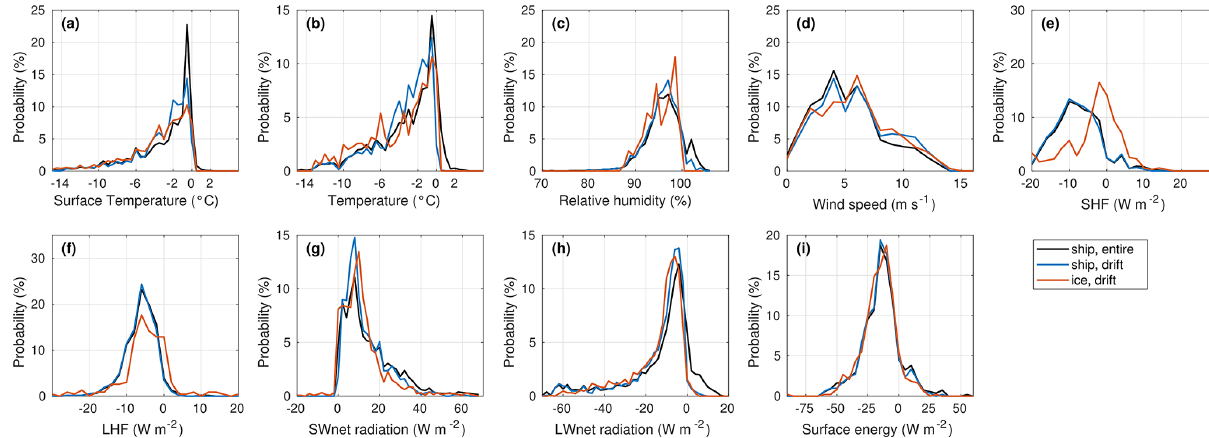
Figure 6. Probability distributions of (a) surface temperature, (b) near-surface air temperature, (c) RHw, (d) wind speed, (e) sensible heat flux, (f) latent heat flux, (g) short-wave net radiation, (h) long-wave net radiation, and (i) surface energy. Data are from measurements on board the ship for the whole measurement period (black lines), for the ice drift period only (blue line), and from the measurement station on the ice floe (orange